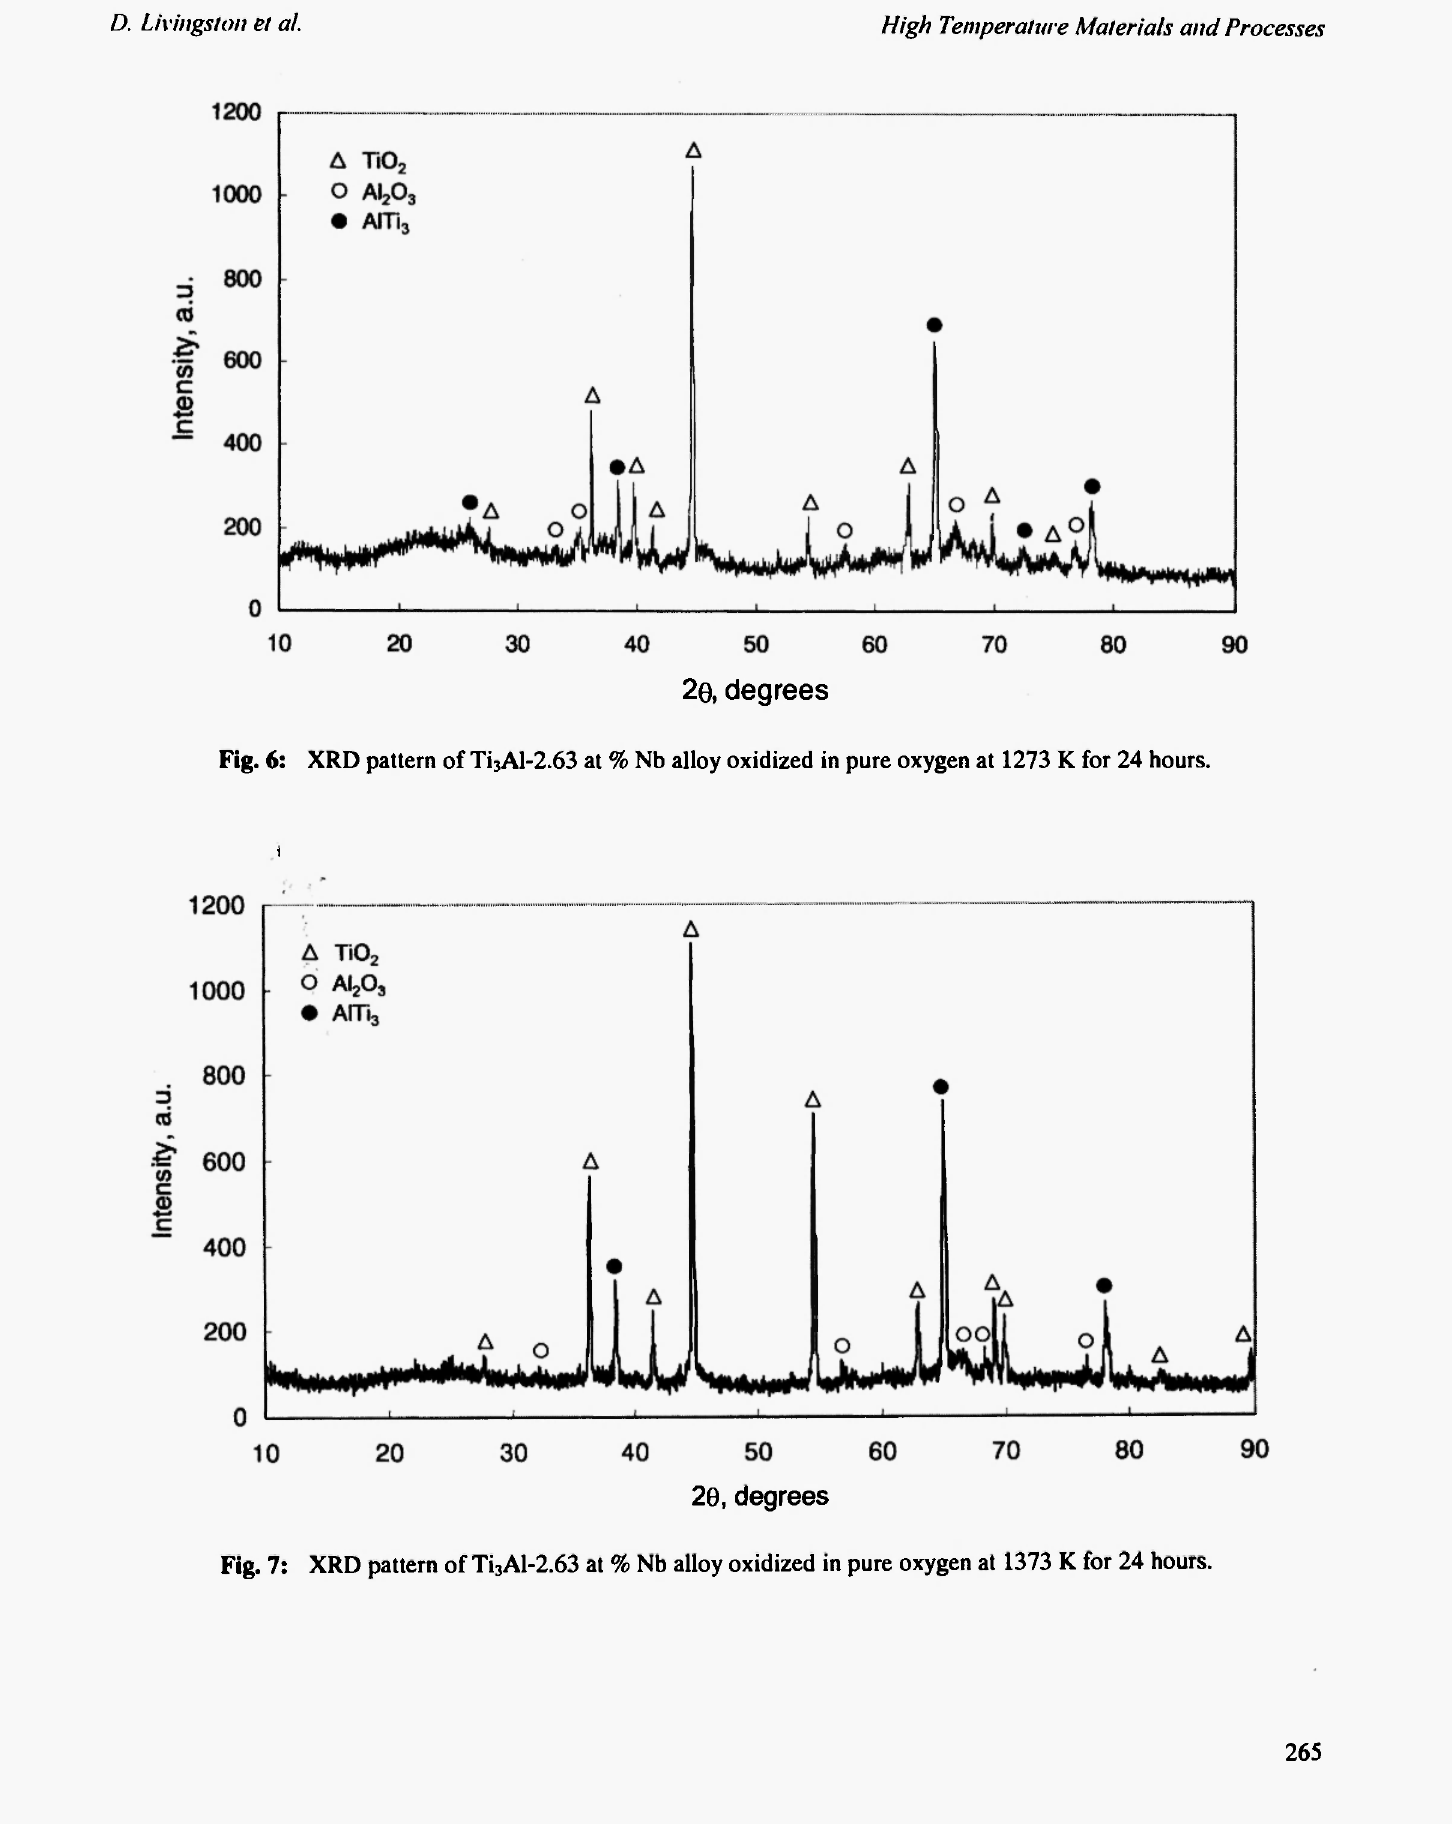
2Θ, degrees Fig. 7: XRD pattern of Ti 3 Al-2.63 at % Nb alloy oxidized in pure oxygen at 1373 Κ for 24 hours.